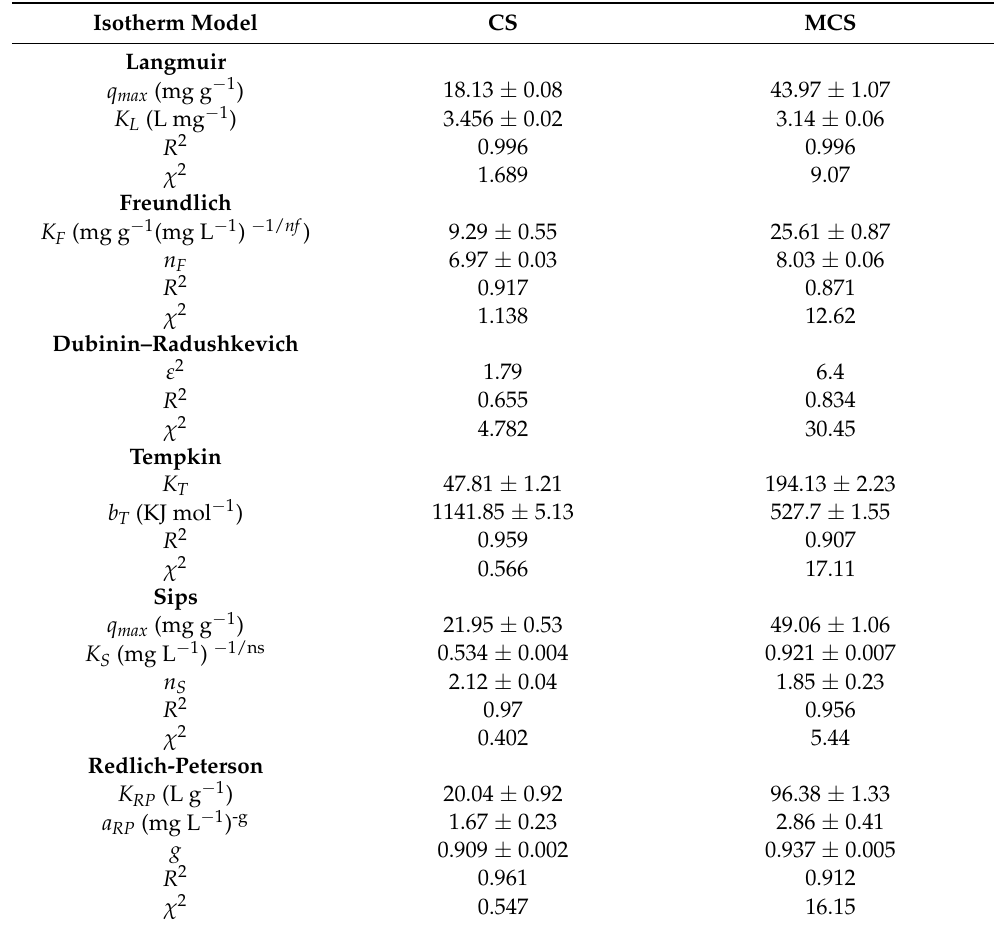
Table 2. Isotherm parameters for Cd 2+ biosorption on the CS. Isotherm